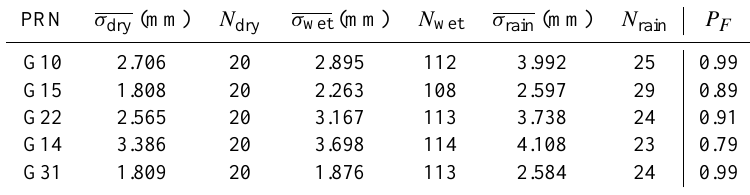
Table 2. Summary of the standard deviation analysis for the polarimetric phase differences under three different meteorological conditions (dry, wet and rain days). σ i and N i account for the mean standard deviation and the number of days used for each meteorological condition group i . P F is the cumulative probability associated with the f statistic comparing the σ of the rain and the no-rain (wet and dry) days. The f statistic is the result of the F test, and P F can be understood as the significance level at which we reject the null hypothesis that both samples come from the same population.